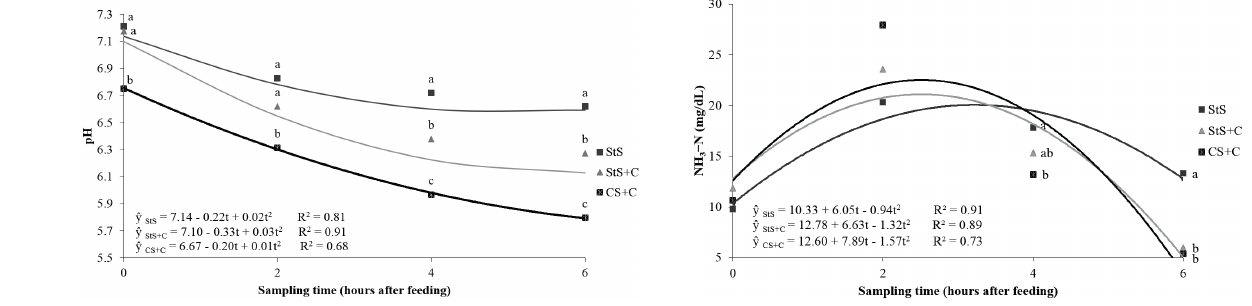
Figure 2 - Concentration of ruminal ammonia nitrogen (NH as a function of sampling time of sheep fed Stylosanthes silage without concentrate (StS), Stylosanthes silage with concentrate (StS+C) and corn silage with concentrate (CS+C). Different letter in the points are significantly based on a Tukey- test (P<0.05). Effects of diets (P=0.78), time (P<0.01) and its interaction (P<0.01); standard error of mean